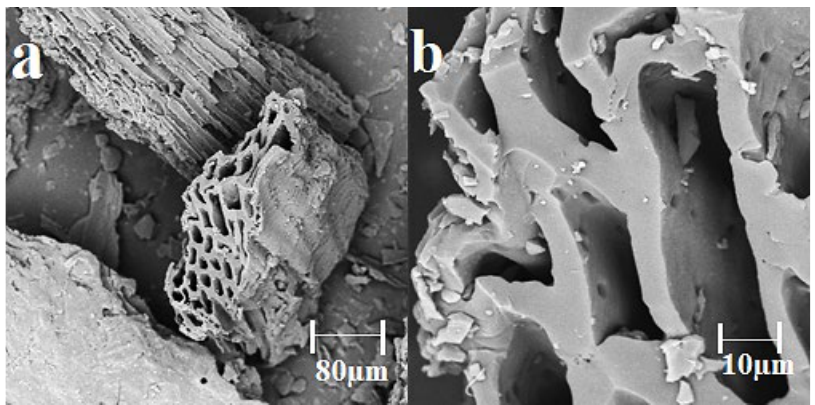
Figure 1. The SEM images ( a ) ×1000 and ( b ) ×8000 of biochar derived from sunflower husks.